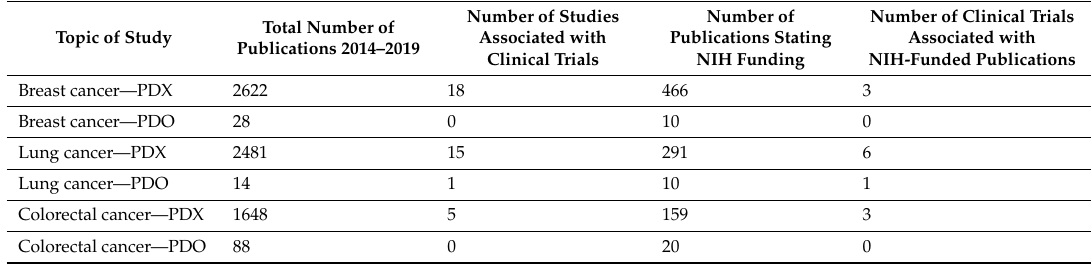
Table 2. Published studies which were funded by, or declared an element of funding by, the US National Institutes of Health (NIH) (excluding reviews) were retrieved from the PubMed database, using search terms defined in the methods, for models of three types of cancer. As an initial, broad measure of assessing impact, the PubMed filter for clinical trials (Article Type) was applied to determine the number of clinical trials associated with particular publications.